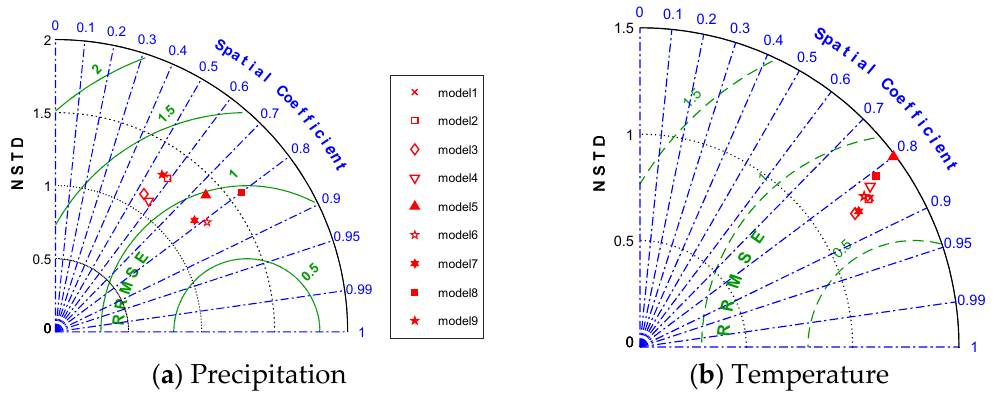
Figure 5. Taylor diagram to examine the performance of various RCMs for the simulation of ( a ) precipitation and ( b ) temperature.